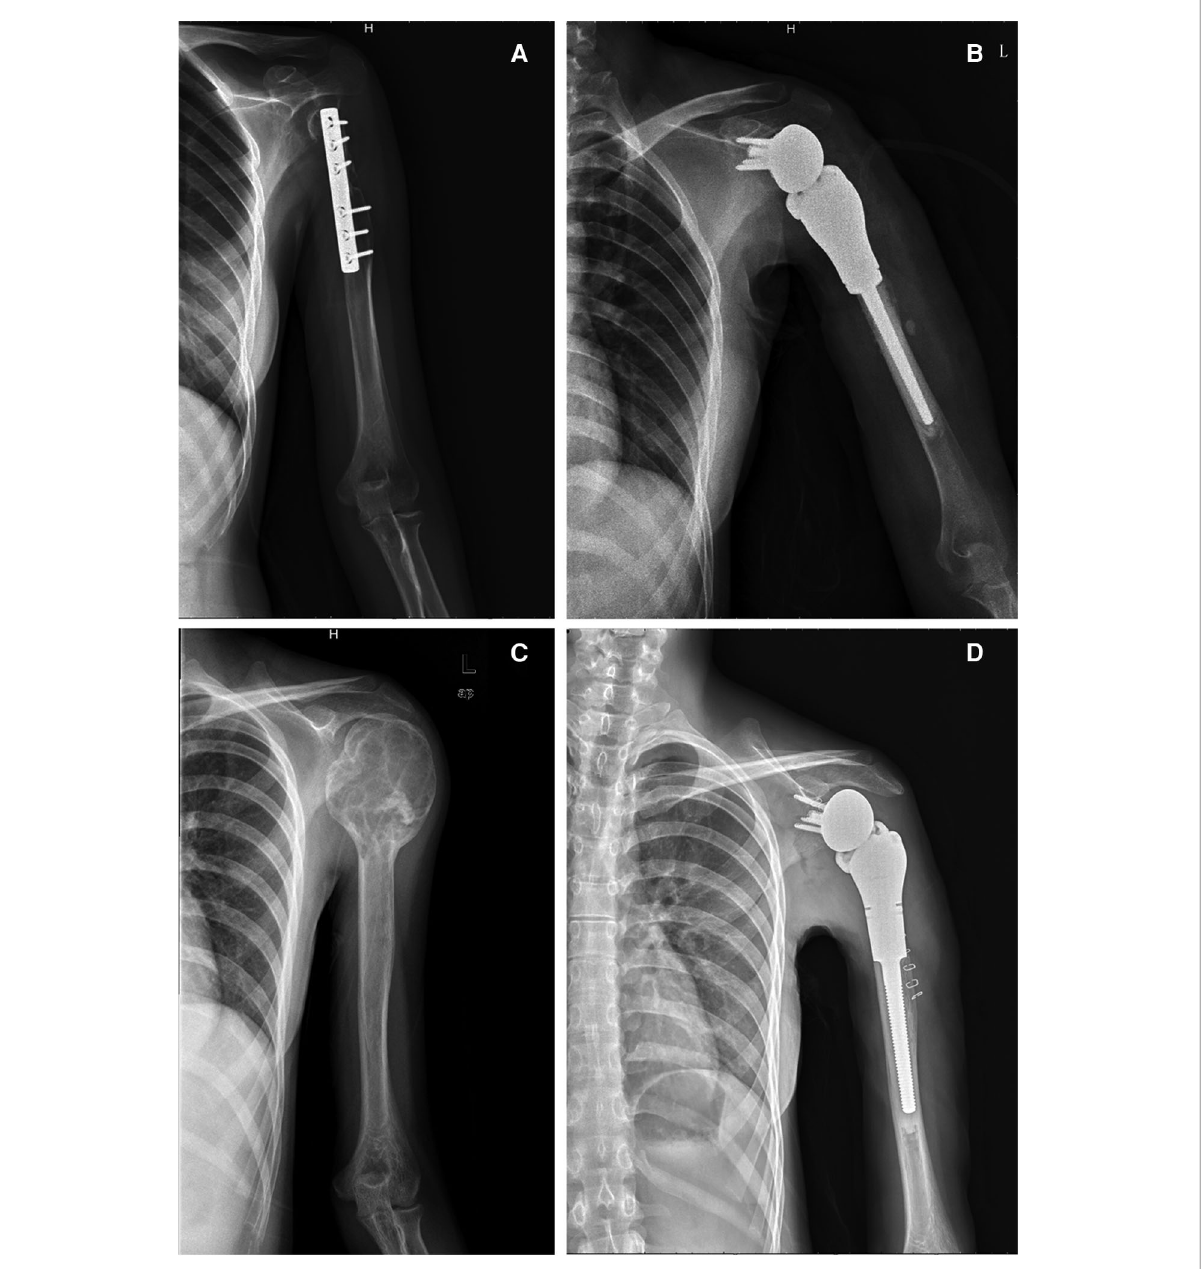
FIGURE 1 Imaging of two typical patients. ( A ) Preoperative x-ray of typical patient 1. ( B ) Postoperative x-ray of typical patient 1. ( C ) Preoperative x-ray of typical patient 2. ( D ) Postoperative x-ray of typical patient